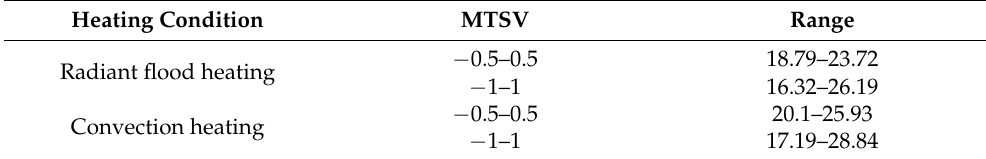
Table 7. Summary of the acceptable temperature